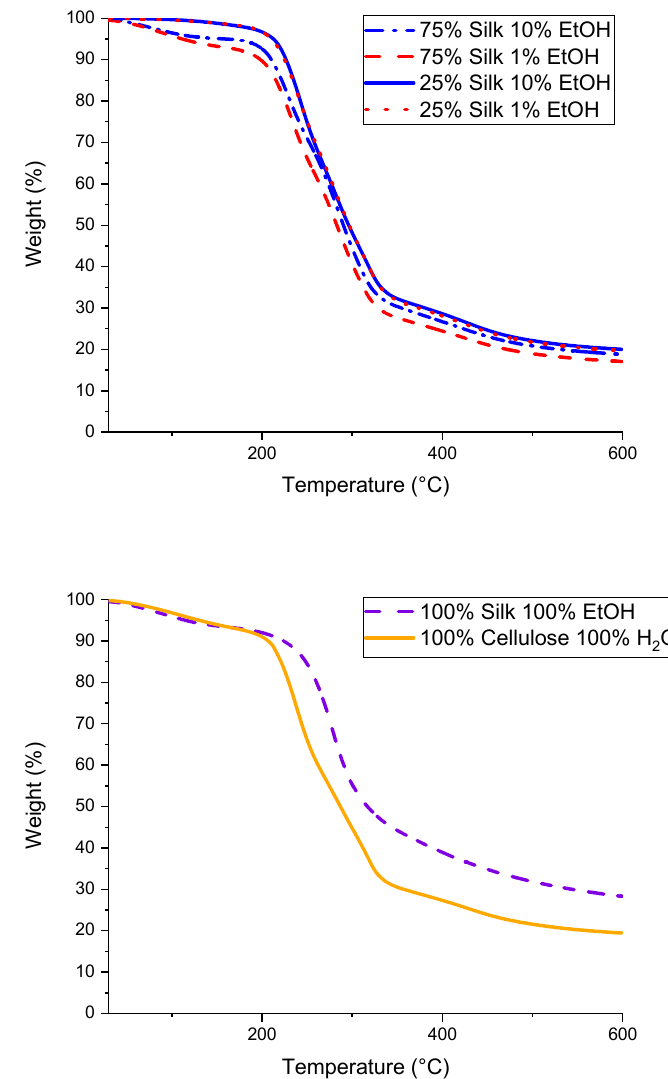
Figure 3. Thermograms of silk / cellulose biocomposites with varied compositions and 100% regenerated samples.